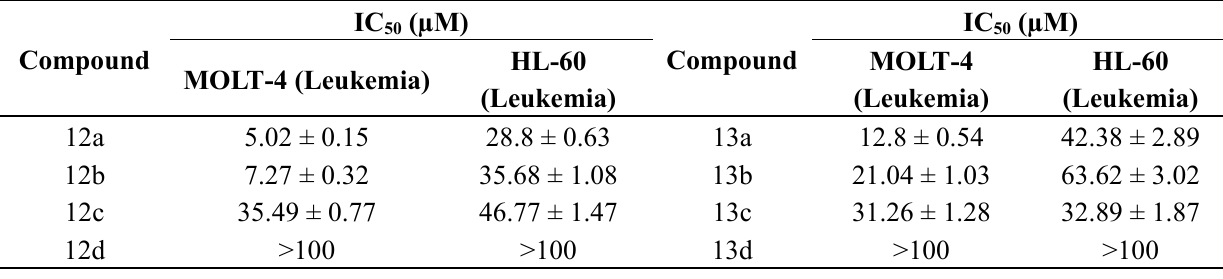
Table 2. Cytotoxic activities of isosteviol derivatives against human leukemia suspension cancer cell lines a